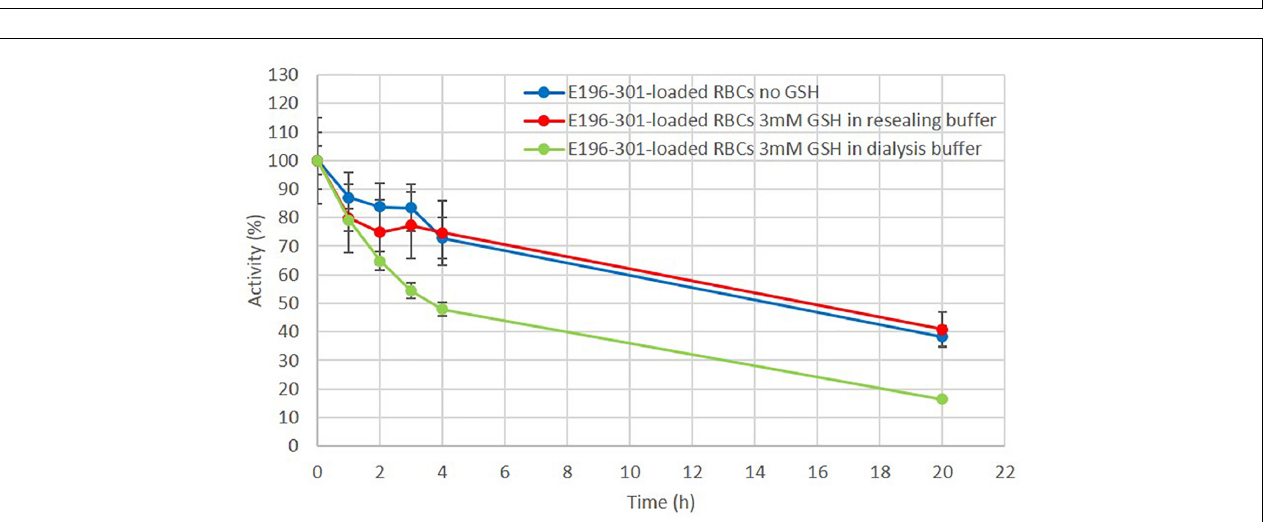
FIGURE 5 | Reduced glutathione (GSH) effect on E196-301 stability. Enzyme activity has been evaluated at different times (0, 1, 2, and 3 h) after incubation at 37 ◦ C in a 1 ml-final volume in the absence or in the presence of different GSH concentration in the range 0.5–3 mM. Values are expressed in percentage respect to time 0. At this time the enzyme activity was 15 IU/ml. This is representative of two different duplicate experiments that agree within 5%.